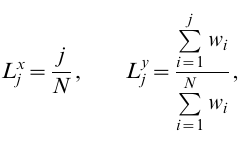
Figure S3 Cohort wealth as a function of time. Cohort 1 ( G 1 ) contains all players who joined Pardus on the first day. Cohort 2 ( G 2 ) contains all players you joined between day 2 and 200, cohort 3 ( G 3 ) all who joined between day 201 and 400, etc.